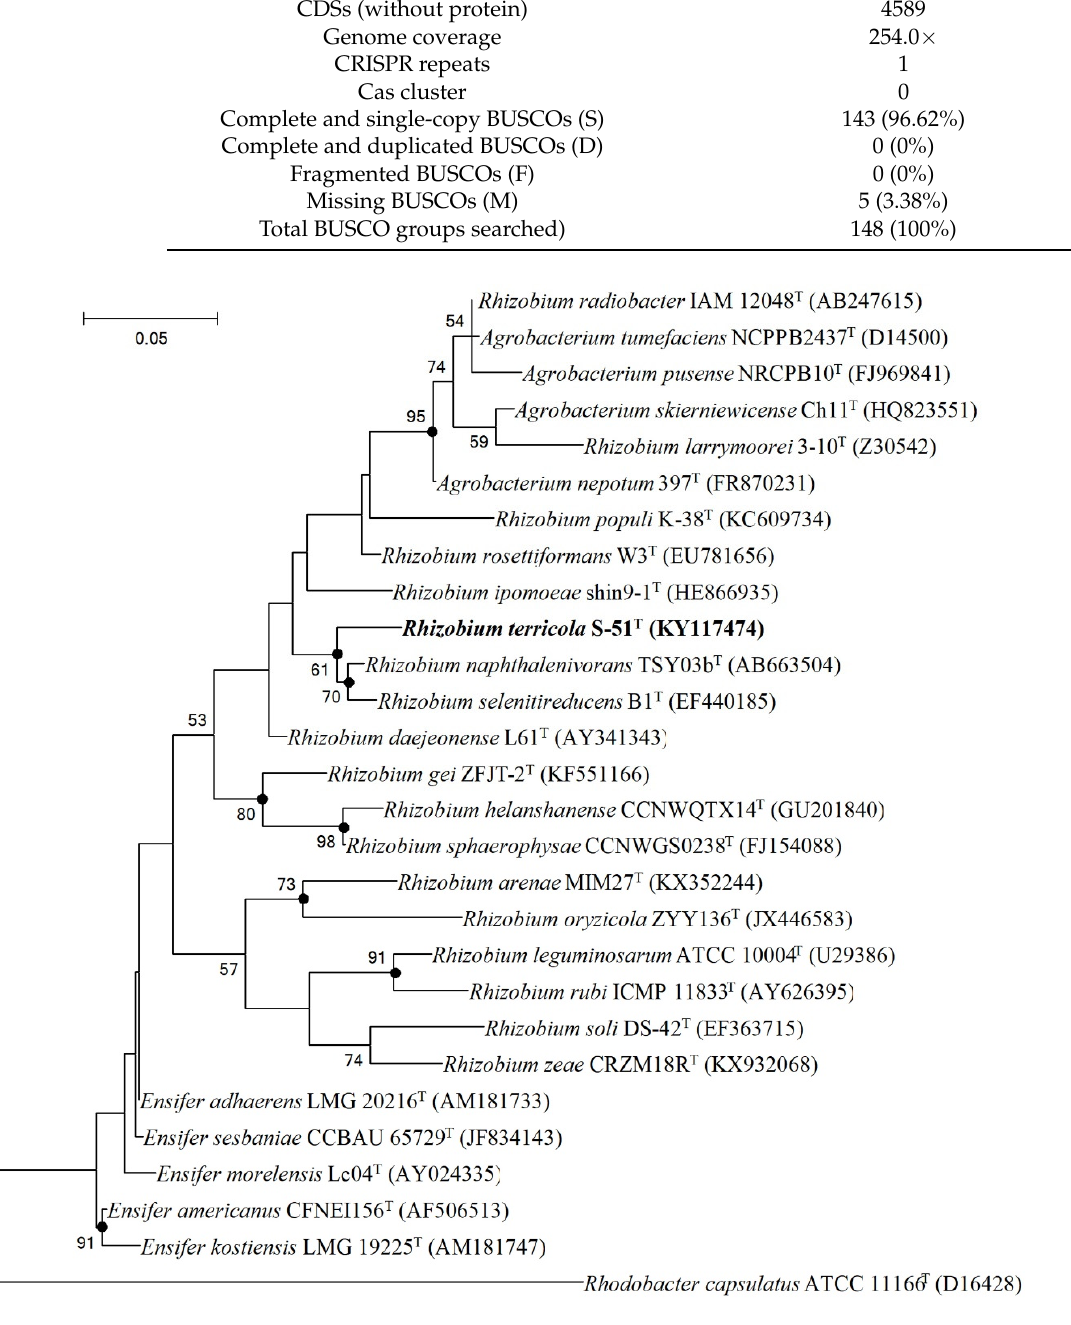
Figure 2. Maximum-likelihood tree based on 16S rRNA gene sequences showing the phylogenetic position of strain S-51 T among closely related members of the family Rhizobiaceae . Filled circles indicate nodes recovered by all three treeing methods (neighbor-joining, maximum-likelihood, and maximum-parsimony). The numbers at the nodes indicate the percentage of 1000 bootstrap replicates yielding this topology; only values >50% are shown. Rhodobacter capsulatus ATCC 11166 T was used as an out-group. GenBank accession numbers are given in parentheses. Bar, 0.05 substitutions per nucleotide position.